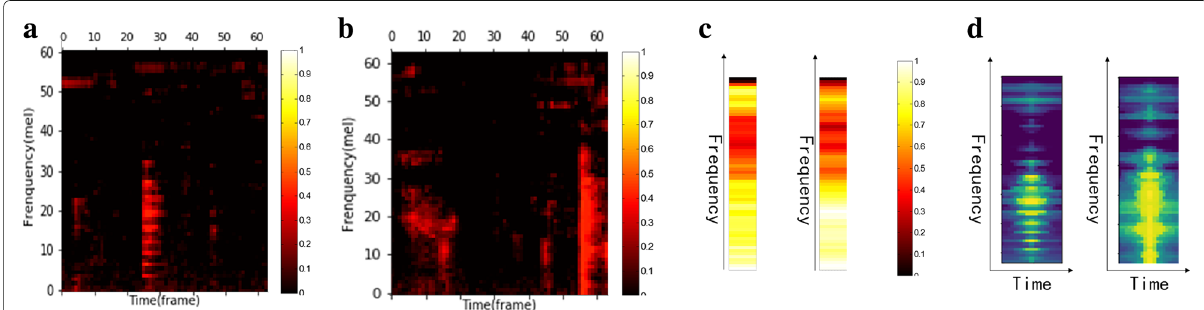
Fig. 1 Spectrogram examples of “cafe” scene. a , b Two audio fragments randomly selected from “cafe” scene. c The average energy distribution of the two examples in frequency direction. d The temporal coherence of the two examples in different frequency